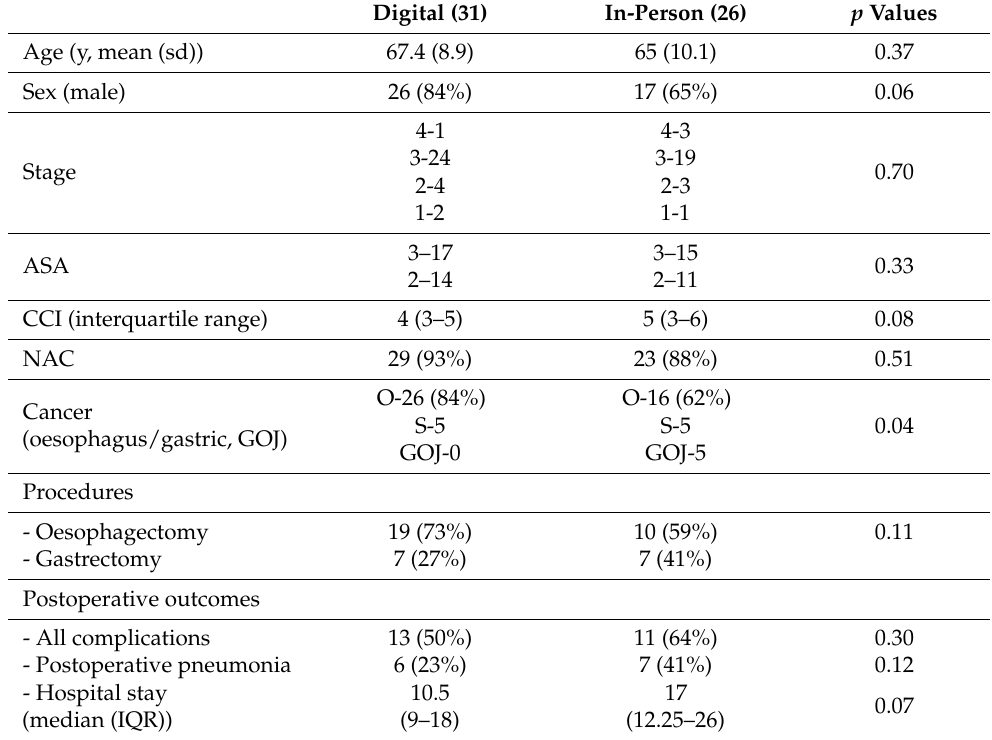
Table 2. Digital Vs. In-person